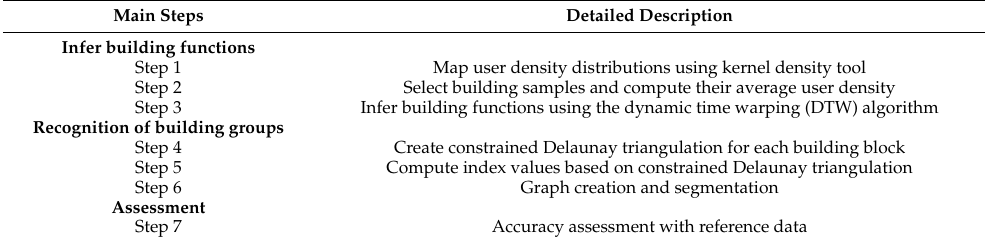
Table 1. Methodological steps.